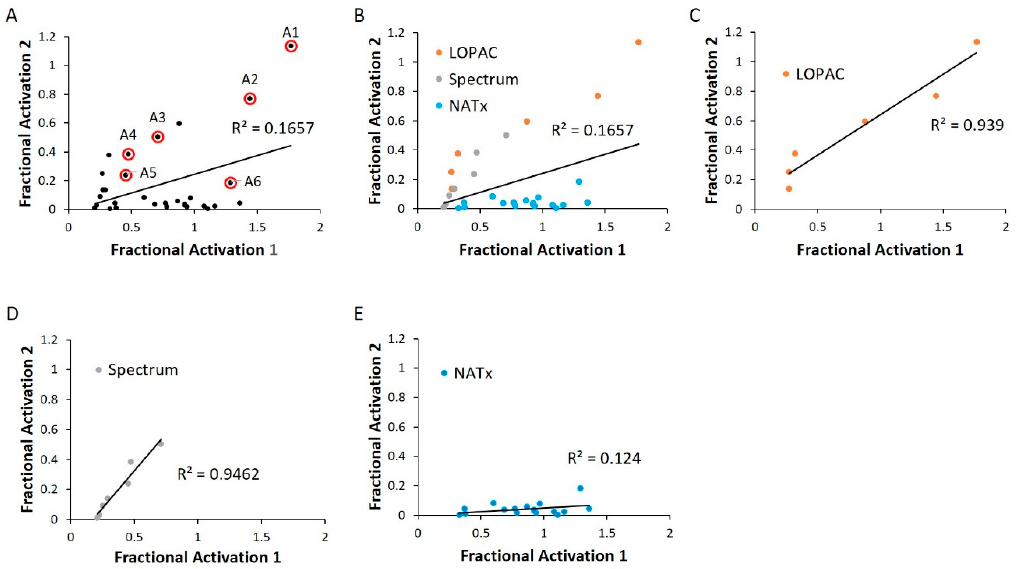
Figure 6. WT HYPE activator validation. ( A ) Comparison between initial HTS compound activity ( x -axis) and second-pass validation ( y -axis) with the same FP AMPylation assay. All validation compounds were assayed on the same plate and normalized to internal positive (E234G HYPE) and negative (WT HYPE) DMSO controls. Each dot represents the same compound incubated in two independent AMPylation reactions. Dots with red circles show hits selected for follow-up, orthogonal validation. ( B – E ) Data reprocessed from ( A ) to show compound validation among the various libraries.